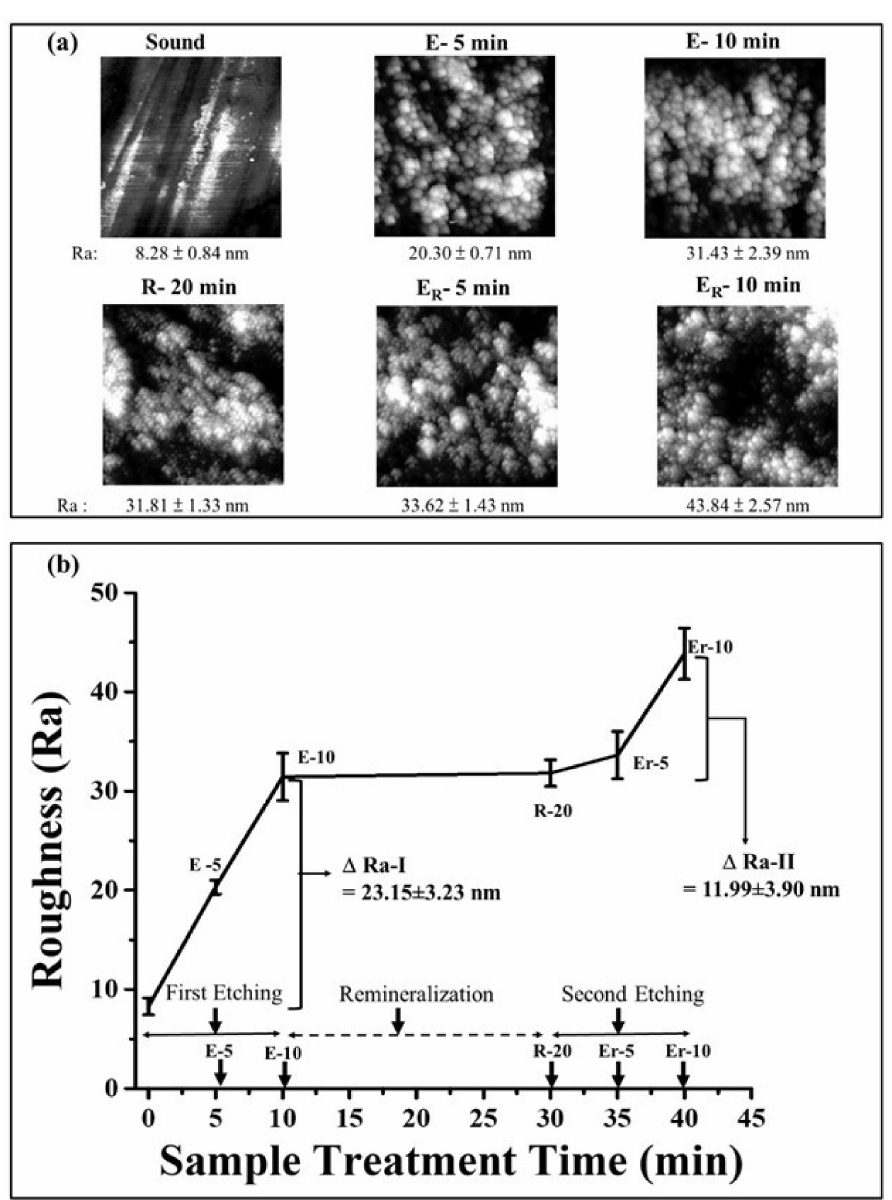
Figure 3. ( a ) AFM micrographs and ( b ) graphical representation of roughness of tooth enamel after demineralization and